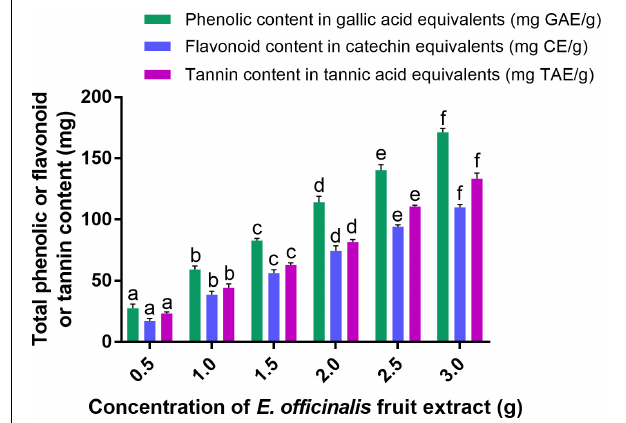
FIGURE 1 | Total phenolic, flavonoid, and tannin contents in aqueous fruit extract of E. officinalis . The experiments were executed independently in triplicates and data was expressed as mean ± SD. The statistical difference between the test samples were assessed by Tukey’s multiple comparison test and p ≤ 0.05 was considered as a significant. The bar graphs with different alphabetic letters within the respective study were